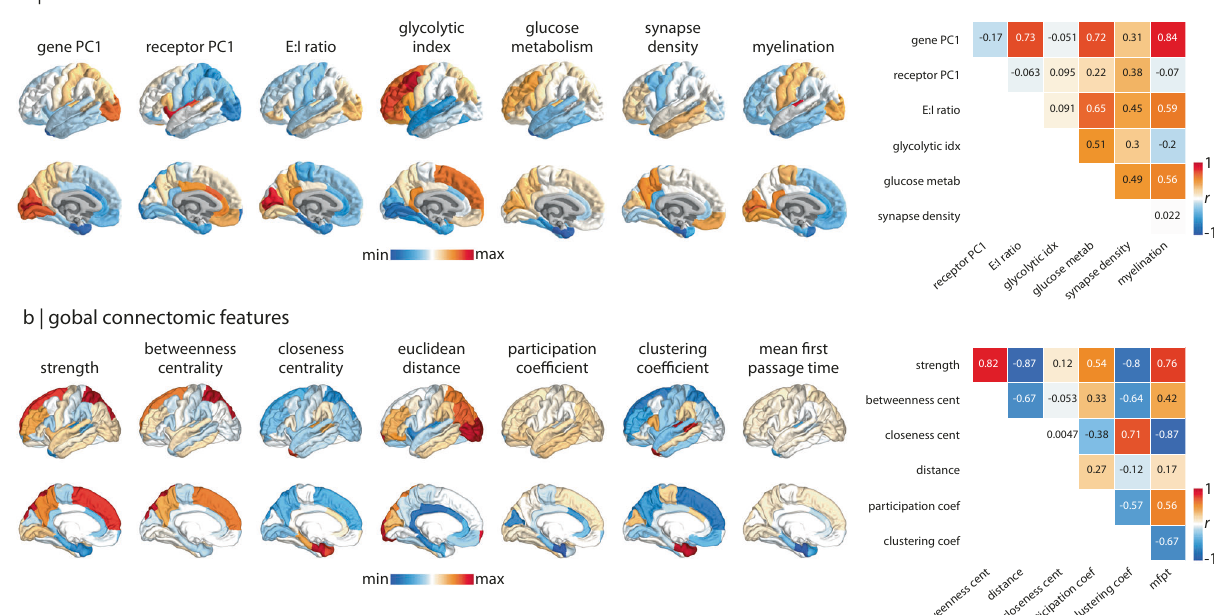
½ 11 C (cid:2) UCB-J PET tracer; myelination=T1w/T2w ratio. Connectivity predictors: strength=sum of weighted connections; betweenness=fraction of all shortest paths traversing region i ; closeness=mean shortest path length between region i andallotherregions;Euclideandistance=meanEuclideandistancebetweenregion i and all other regions; participation coef fi cient=diversity of connections from region i to the seven Yeo-Krienen resting-state networks 164 ; clustering=fraction of triangles including region i ; mean fi rst passage time=average time for a random walker to travel from region i to any other